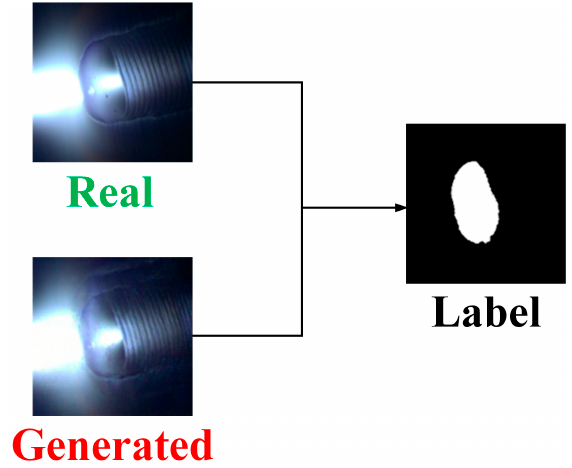
Figure 7. Generated images, real images and their corresponding label.